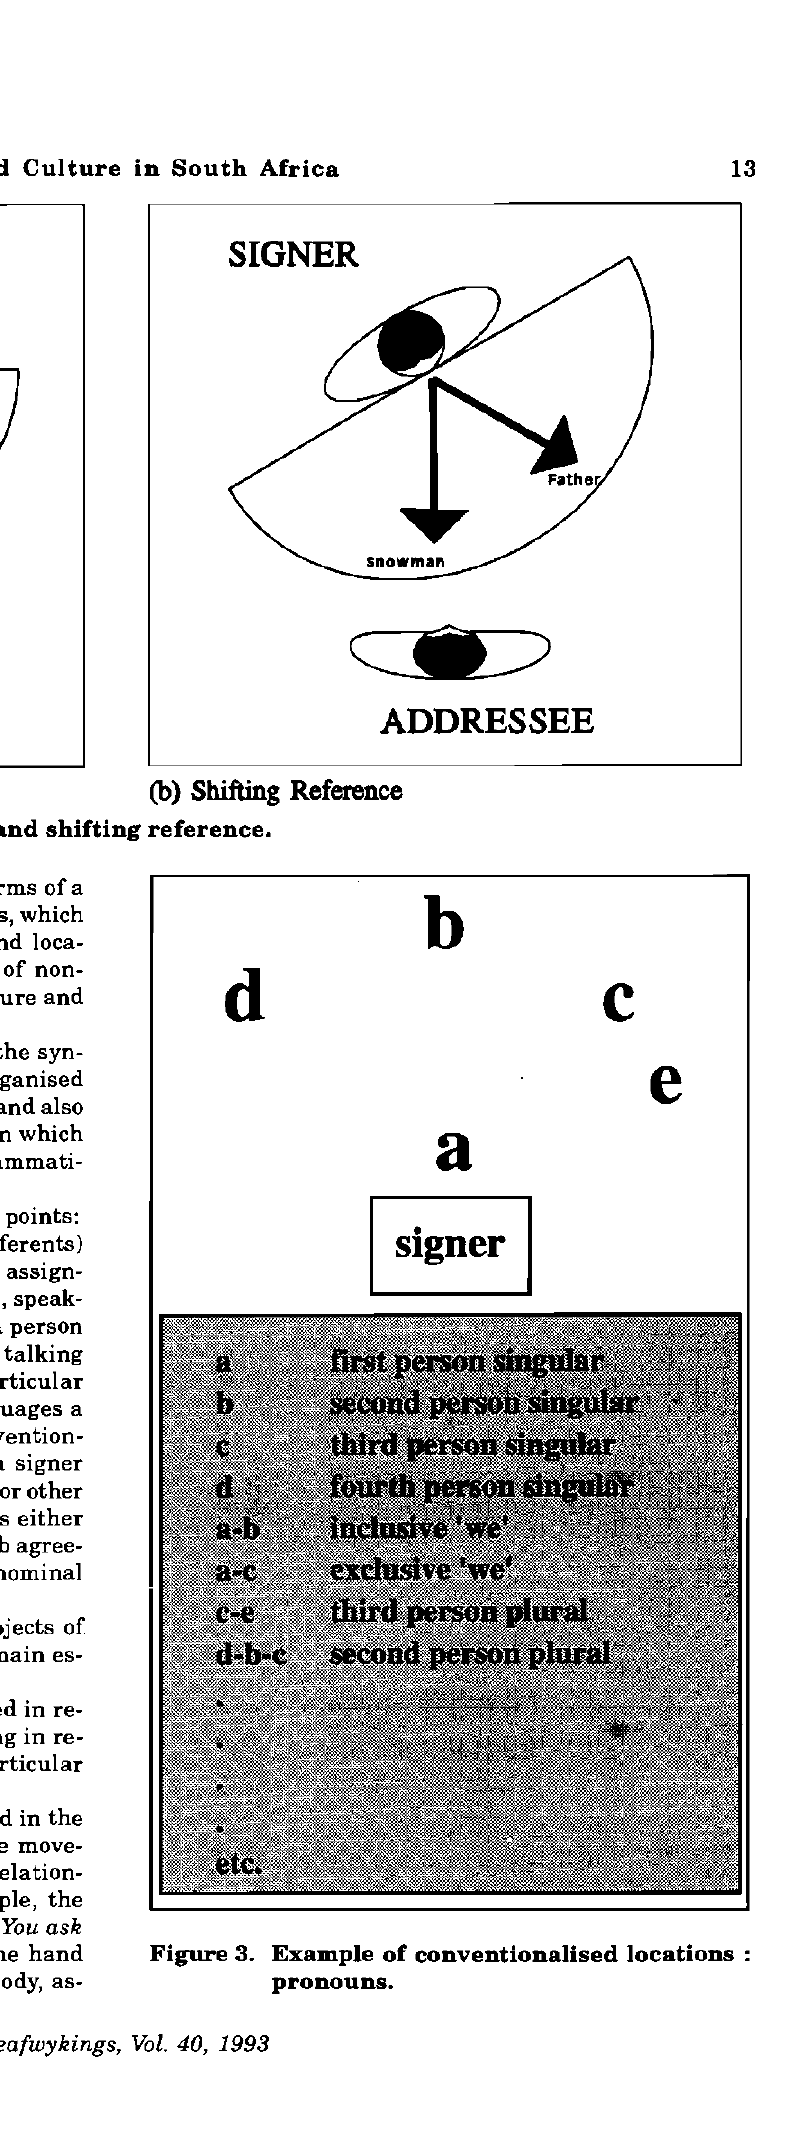
Figure 3. Example of conventionalised locations